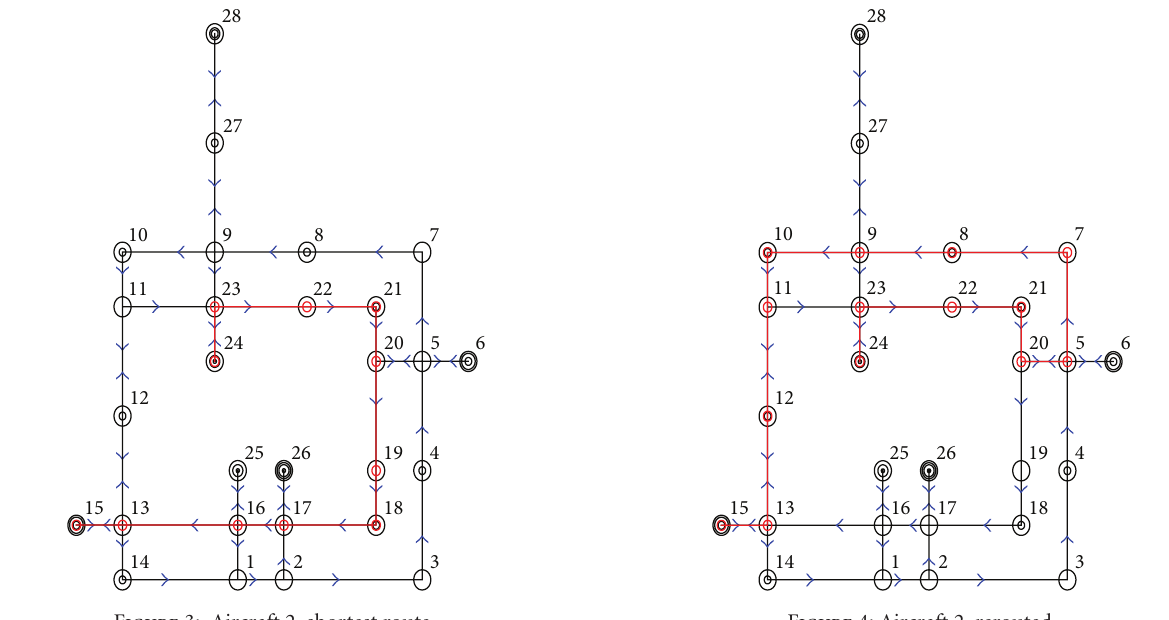
Figure 3: Aircraft 2, shortest route. Figure 4: Aircraft 2,